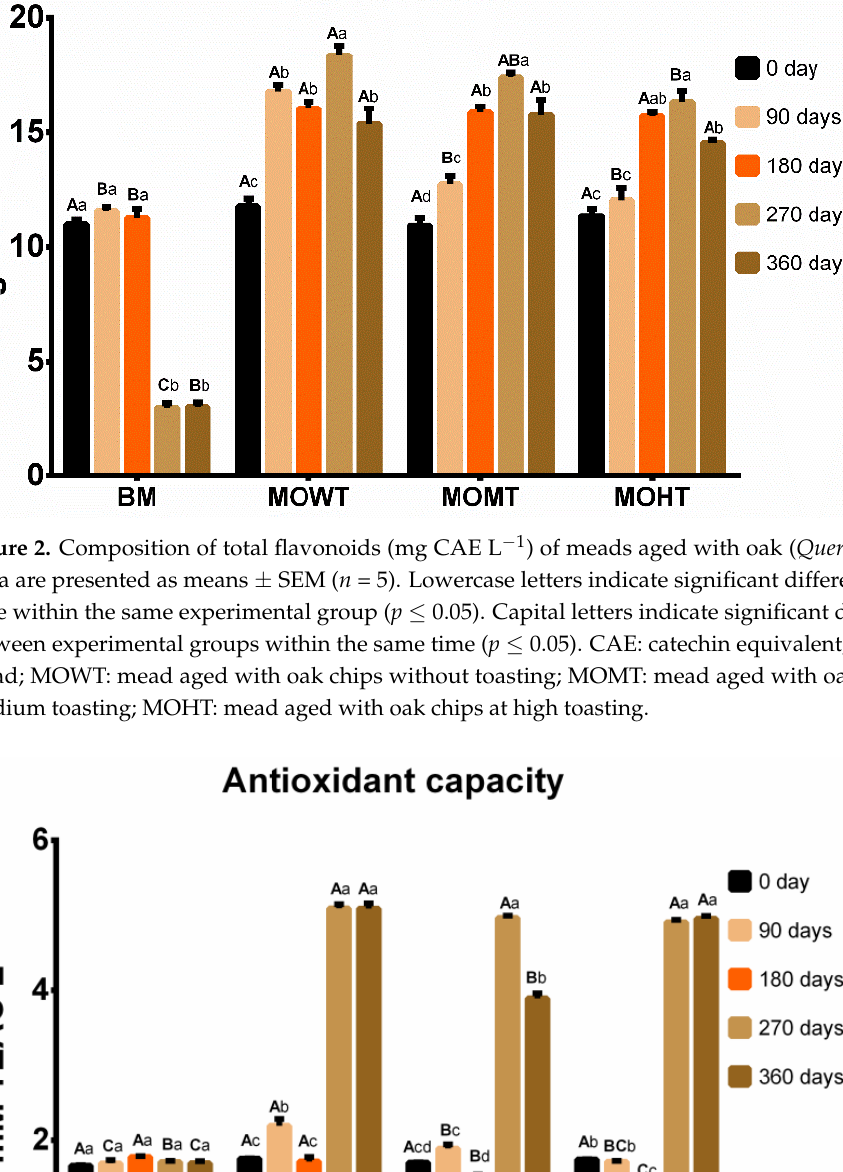
Figure 3. Antioxidant capacity (mM TEAC L − 1 ) of meads aged with oak ( Quercus ) chips. Data are presented as means ± SEM ( n = 5). Lowercase letters indicate significant differences over time within the same experimental group ( p ≤ 0.05). Capital letters indicate significant differences between